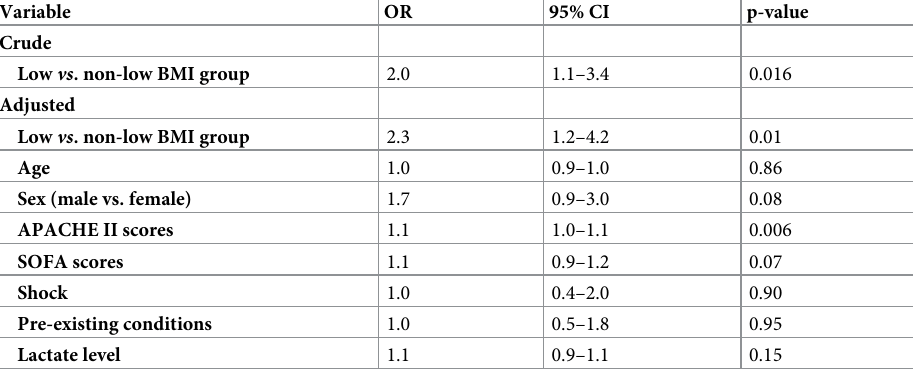
Table 5. Association between BMI and 28-day mortality in patients with sepsis.